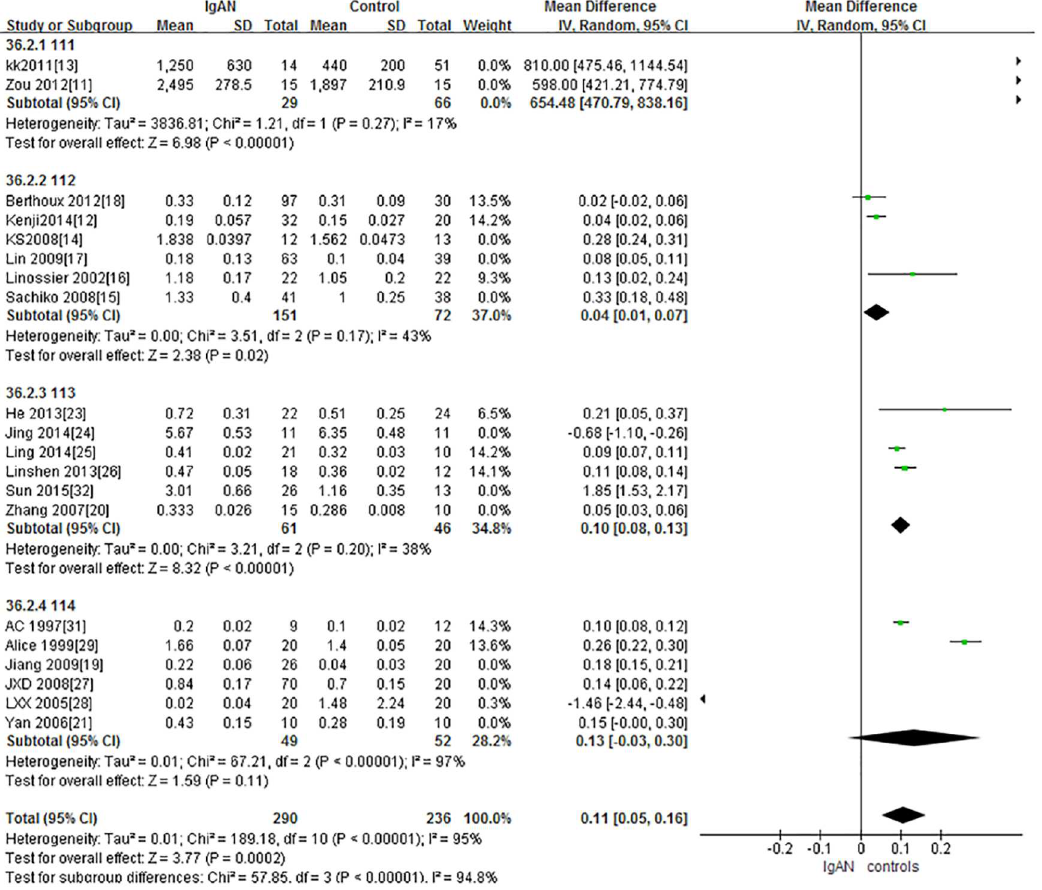
Fig 2. The forest plots of the comparation between IgAN group and control